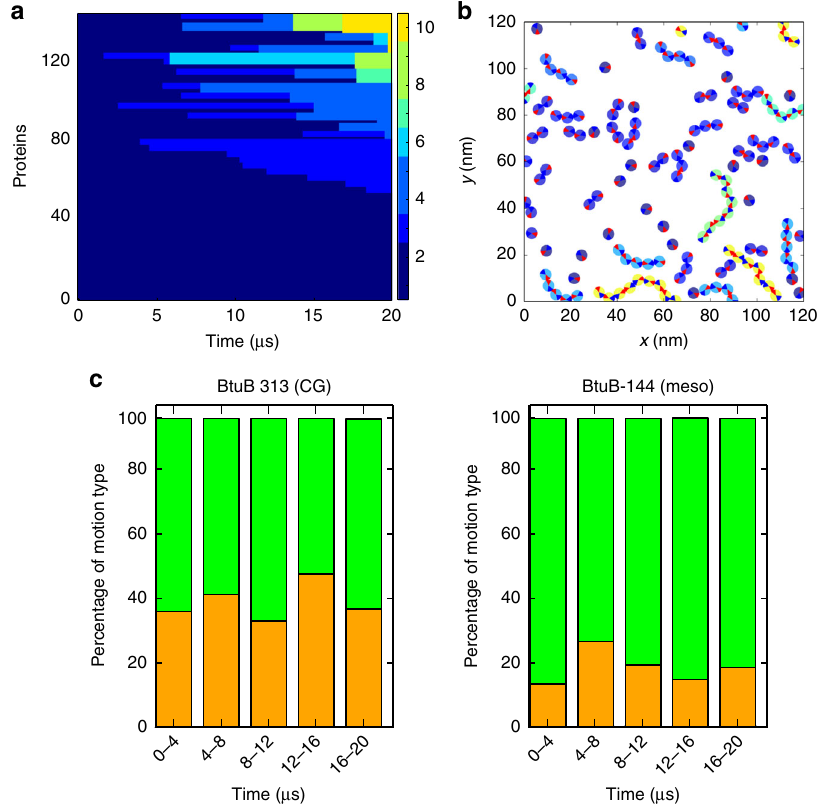
Fig. 6 Mesoscale simulation of a BtuB-containing membrane. a Clustering as a function of time in a mesoscale simulation of 144 BtuB molecules (at 313 K) for 20 µ s. Cluster size is shown by the colour bar. b Snapshot of the same simulation as in a at 20 µ s. Proteins are coloured by cluster size, as in a . Protein interactions interfaces are shown as blue and red wedges on each protein. c Fraction of different classes of diffusional motion for equivalent coarse-grained (left) and mesoscale (right) simulations (as analysed using PaTrack 39 ; see Fig. 3) over 20 µ s of each simulation. Motions are classi fi ed as Brownian (green), or mixed Brownian and con fi ned